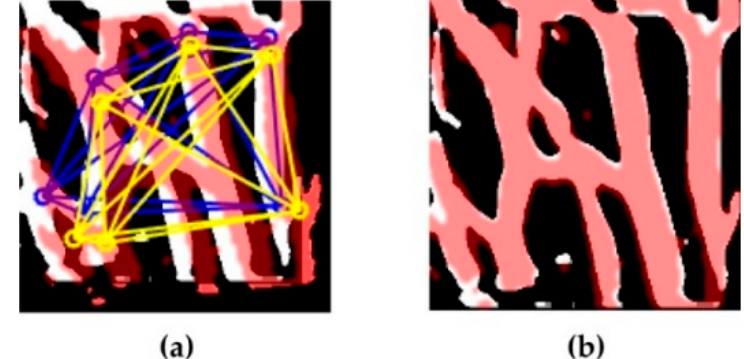
Figure 24. Two vein patterns before ( a ) and after ( b ) alignment in the presence of affine transformation. Table 1. Average distance map and alignment errors of the two vein patterns after performing affine transformation.